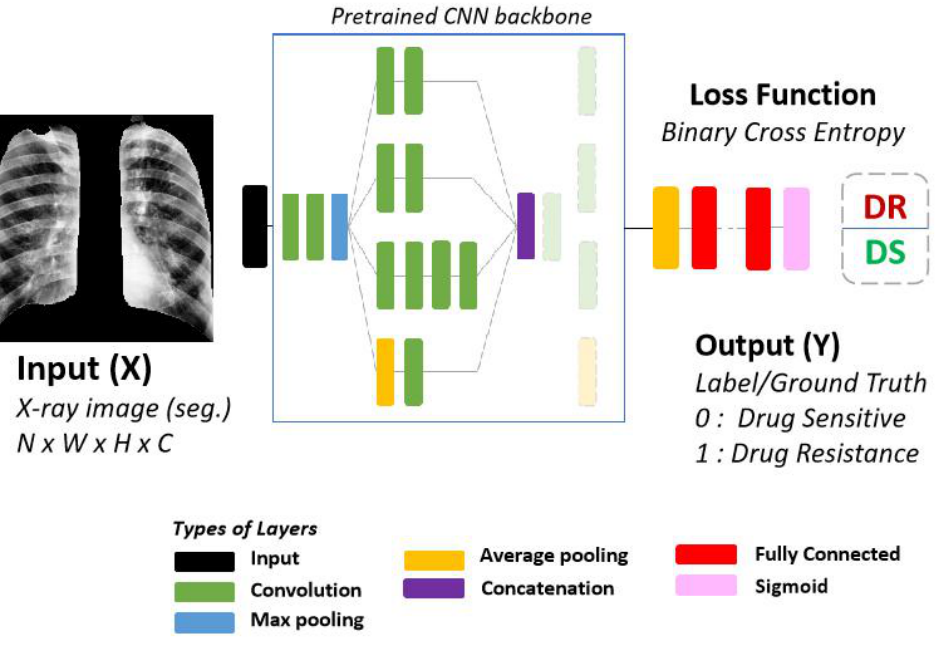
Figure 5. Standard CNN architecture for drug resistance classification. The Input (X) is a preprocessed X-ray image with segmented lungs. The Output (Y) is one of two classes, DR-TB or DS-TB. For this work, we use the ResNet18 [33] architecture as the backbone for all of our